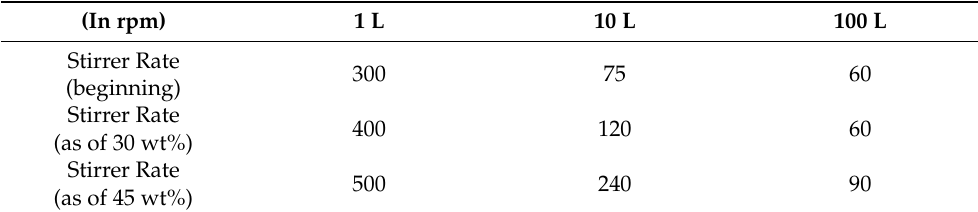
Table 2. Overview of the stirring rates during the emulsion polymerisation in all three reactor